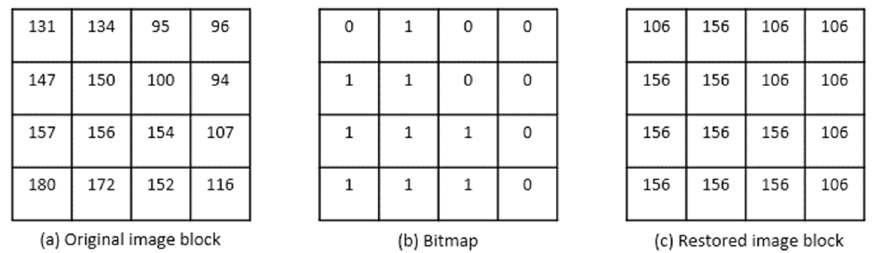
Figure 1. Example of AMBTC Compression: ( a ) Original image block, ( b ) Bitmap and ( c ) Restored image block.